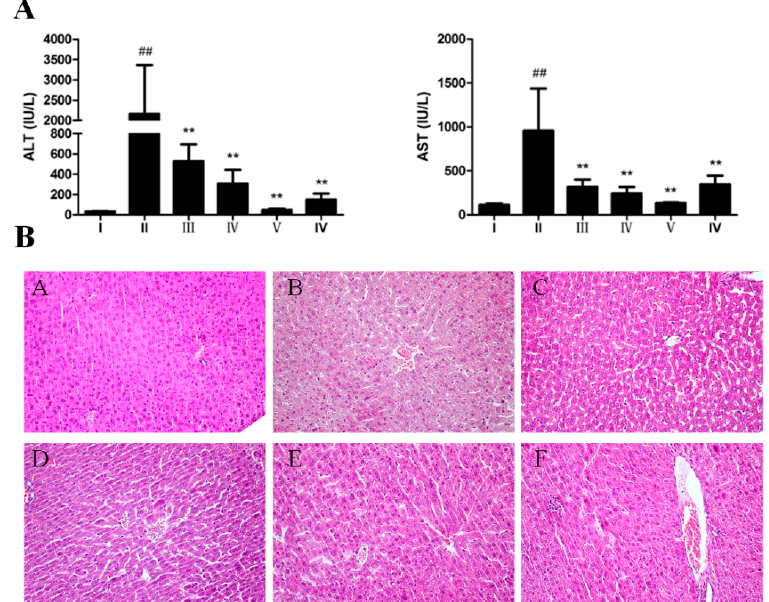
Figure 2. The effect of AEOV on CCl 4 -induced liver injury. ( A ) Serum levels of alanine aminotransferase (ALT) and aminotransferase (AST). Groups are as follows. I: saline; II: saline + CCl 4 ; III: AEOV 125 mg/kg + CCl 4 ; IV: AEOV 250 mg/kg + CCl 4 ; V: AEOV 500 mg/kg + CCl 4 ; VI: biphenyldicarboxylate 150 mg/kg + CCl 4 . Values are the means ± standard error of the mean (SEM) of three independent experiments. ## p < 0.01 versus normal control group, ** p < 0.01 versus CCl 4 -treated group; ( B ) Hematoxylin and eosin (H&E) staining of livers. Mice were treated with saline, AEOV (125, 250, and 500 mg/kg), and biphenyldicarboxylate 150 mg/kg for 4 days, and were then injected subcutaneously with 0.1% CCl 4 dissolved in corn oil. Sixteen hours later, mice were sacrificed and livers were excised and stained with hematoxylin and eosin (400×). Groups are as follows. A: saline; B: saline + CCl 4 ; C: AEOV 125 mg/kg + CCl 4 ; D: AEOV 250 mg/kg + CCl 4 ; E: AEOV 500 mg/kg + CCl 4 ; F: biphenyldicarboxylate 150 mg/kg + CCl 4 .